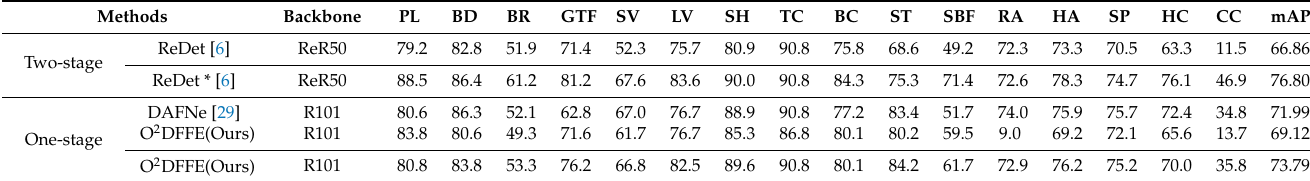
Table 2. Evaluation results on DOTA1.5 datasets. R101 denotes ResNet101. ReR50 denotes ReRes- Net50. * denotes multiscale training and multiscale testing.